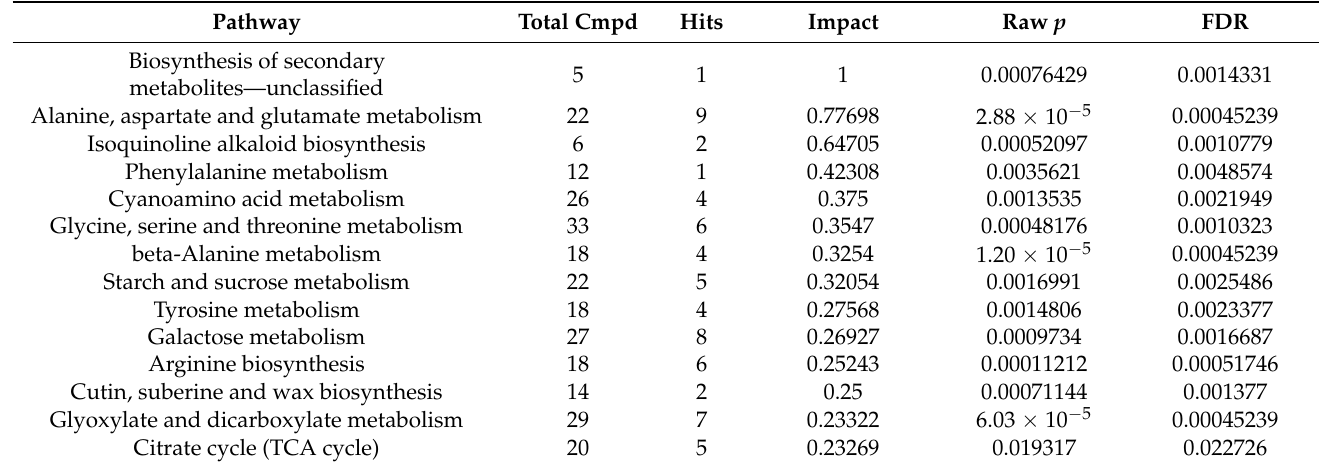
Table 1. Results from ingenuity pathway analysis with MetPa carried out on Zea mays roots treated with 103 µ M trans -cinnamic acid after exposure to various times with the